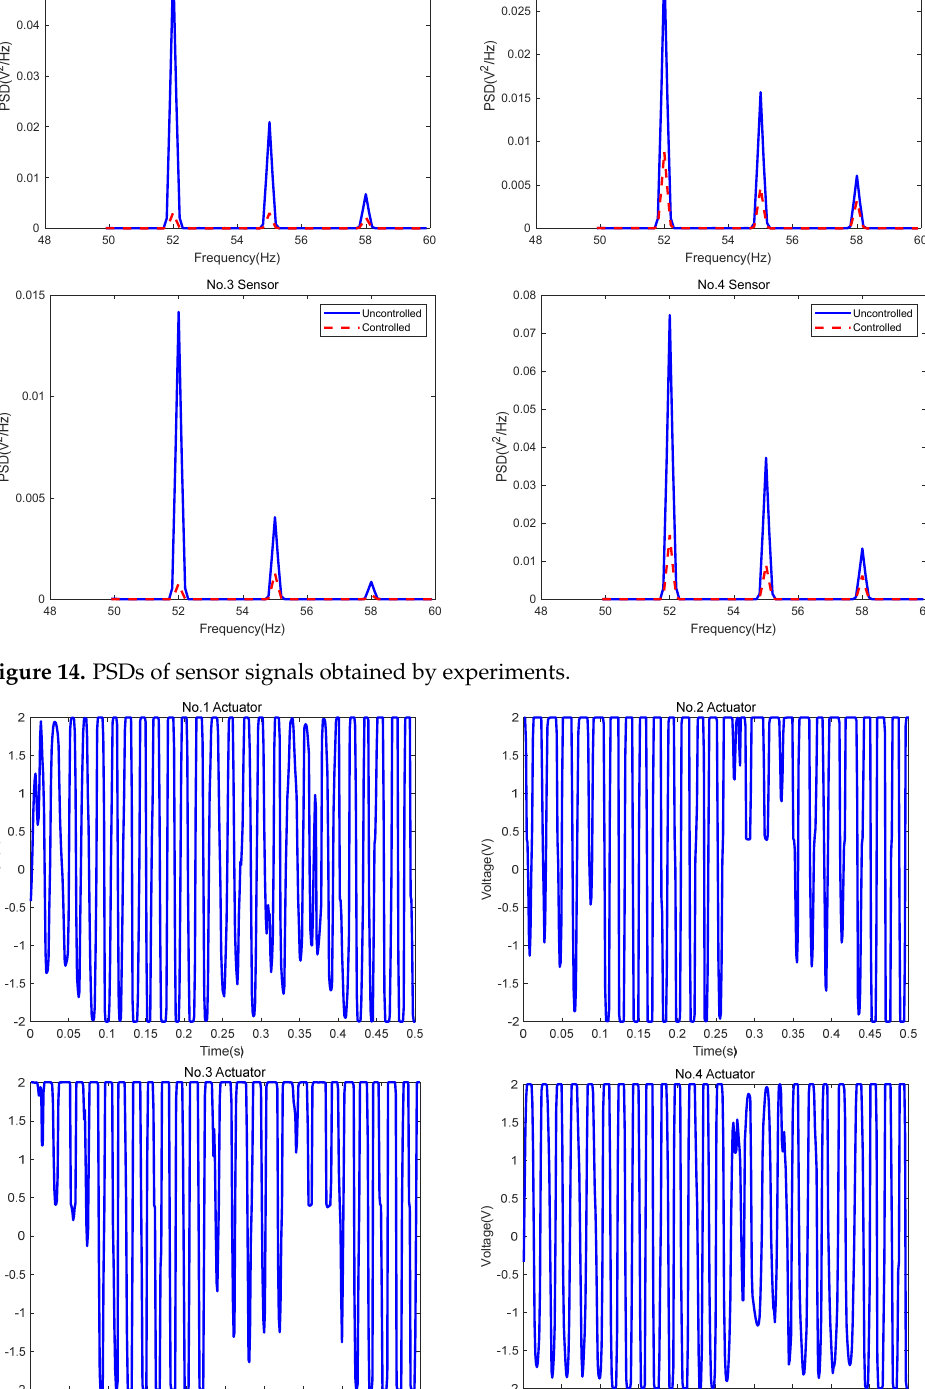
Figure 15. Actuator control signals obtained by experiments (1 V represents 12.3 N).